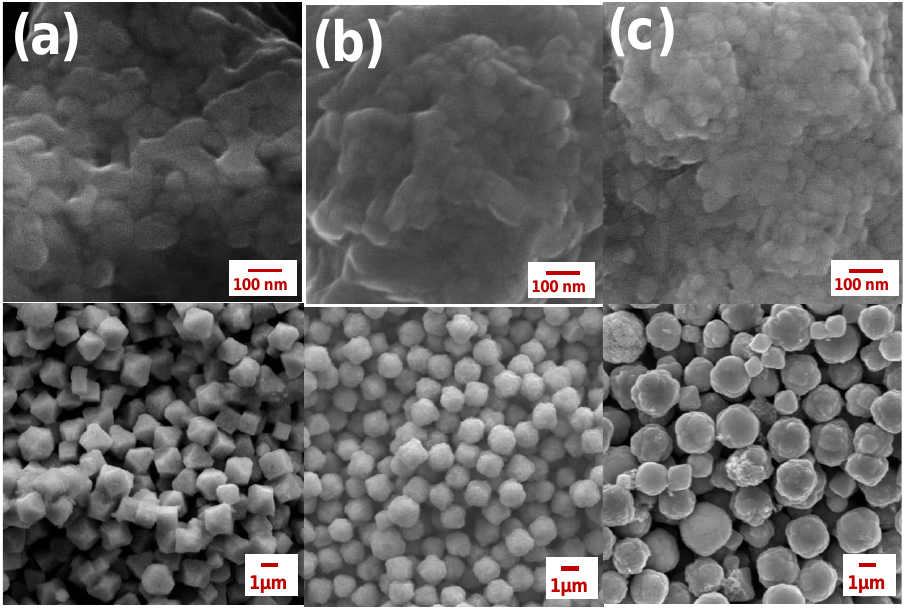
Figure 4. FESEM images of pure and Zn-doped CuO films for ( a ) P, ( b ) S3, and ( c ) S6.